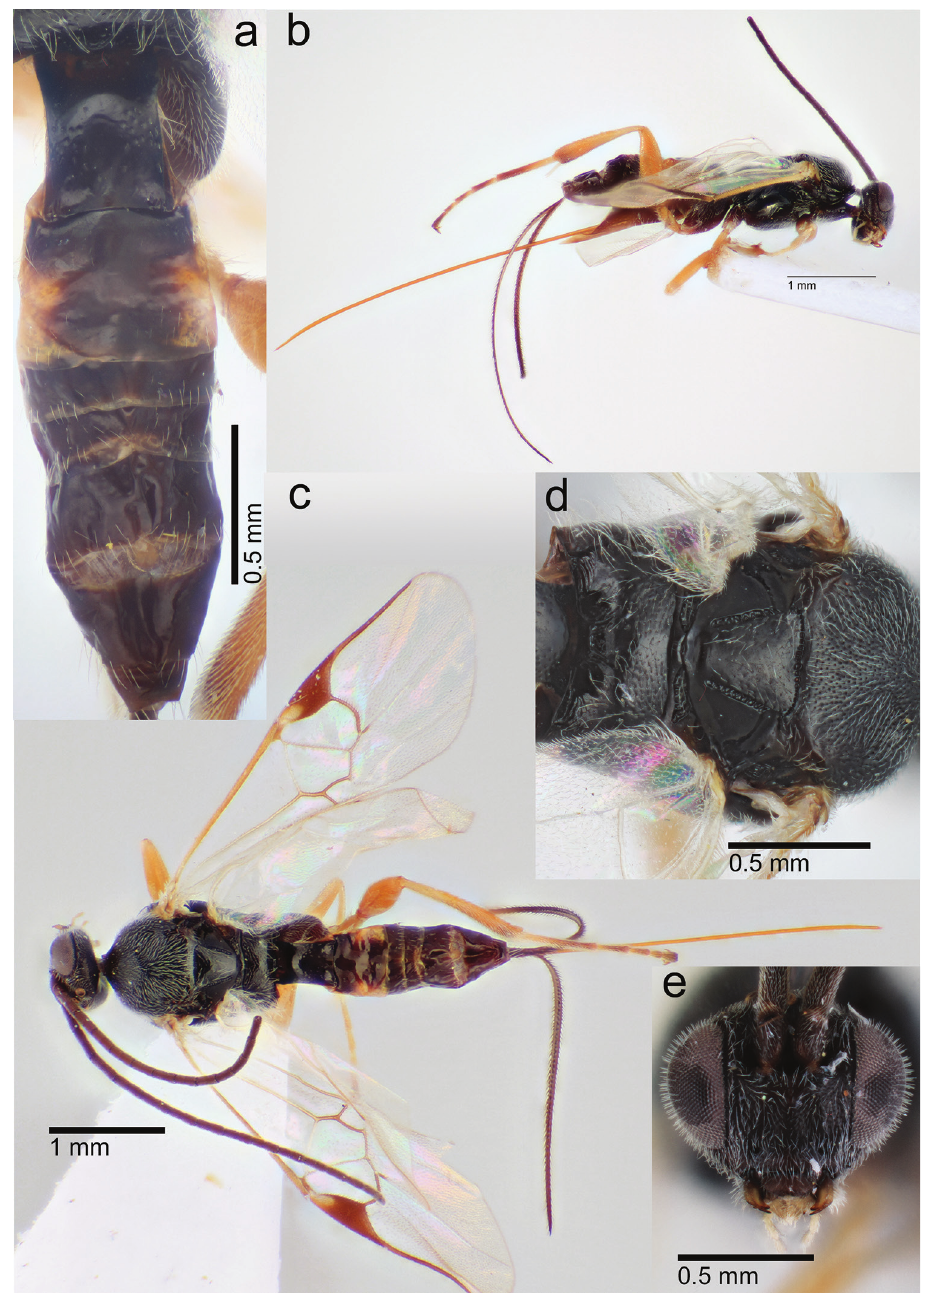
Figure 2. Dolichogenidea finchi (holotype): a metasoma b lateral habitus c dorsal habitus d mesosoma e